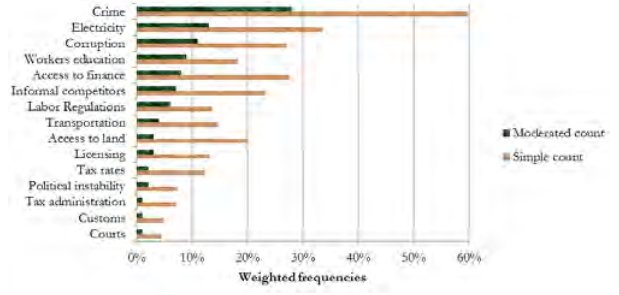
Figure 1: Rating of constraints by firms in South Africa Source: Authors' estimations based on World Bank Enterprise Surveys of South Africa (2007)